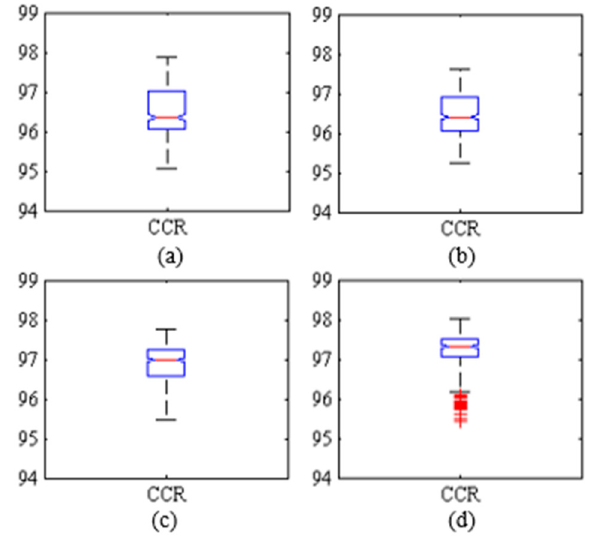
Figure 3. Boxplots of the correct classification rate (CCR) obtained by the classifiers for the 500 iterations on the test data. ( a ) Hybrid ANN-BA; ( b ) Hybrid ANN-BBO; ( c ) Hybrid ANN-FA; ( d ) Voting method.